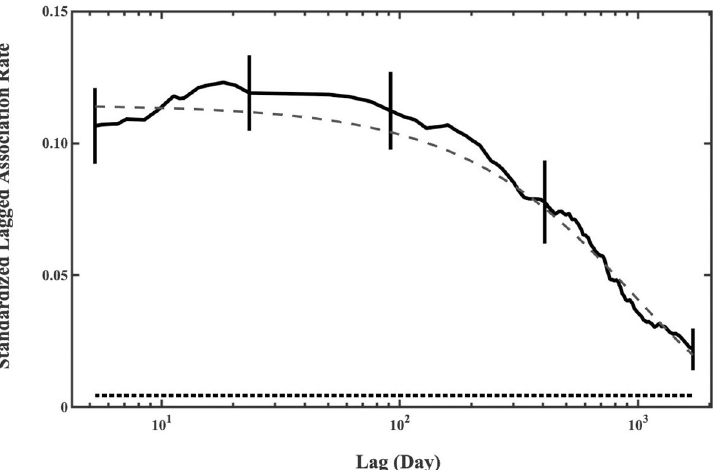
Fig 3. Standardized lagged association rate for males in the Nemuro Strait, with jack-knifed estimates of precision. The SLAR (black line), SNAR (dot line; the theoretical SLAR if the individuals are randomly associated) and best-fitting model (broken line) are shown for the males in Nemuro Strait.